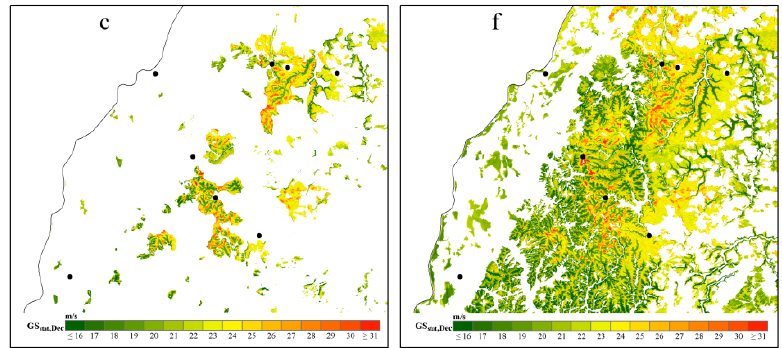
Figure 13. Map extract showing ( a – c ) DAM emp,30yr , DAM mod,30yr , GS stat,Dec for state forests; ( d – f ) FOR , DAM mod,30yr and GS stat,Dec over all types of forest ownership in the northern Black Forest. The black dots indicate the locations of meteorological stations in this area used to build the gust speed model. The legend values indicate highest class values.